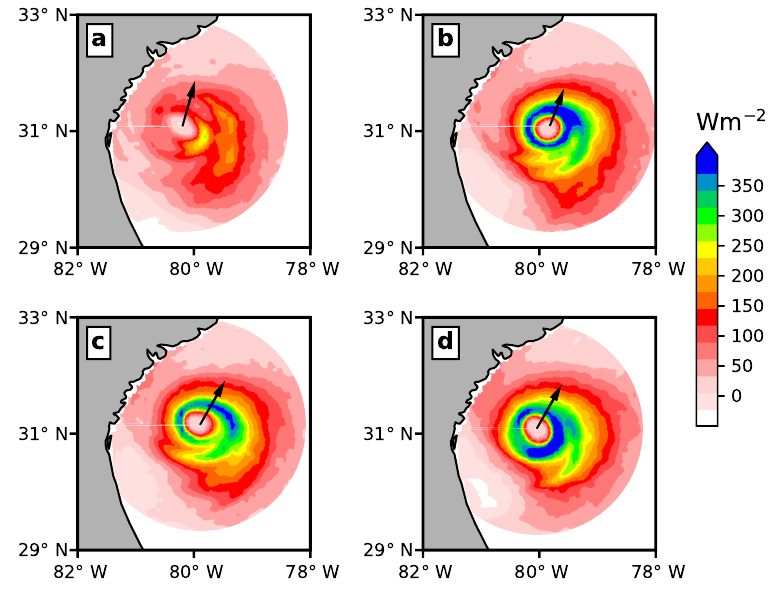
Figure 13. Plan views of surface sensible heat flux for (a) Expt. 1, (b) Expt. 2, (c) Expt. 3, and (d) Expt. 4 at 00:00UTC on 3 July 2014. The black arrow indicates the hurricane translation direction over a 3h